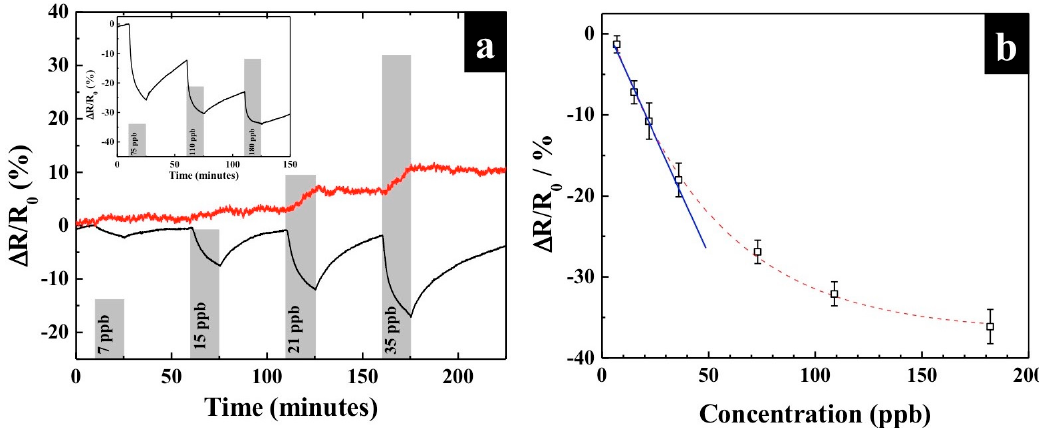
Figure 2. ( a ) Dynamic responses ( Δ R / R 0 ) of KI-functionalized PANI nanothin film (KI-PANI, black) and pristine PANI (red) sensors to 7–35 ppb of ozone gas at 25 °C and 50% RH. The inset shows sensing response of 75–180 ppb of ozone gas; ( b ) Calibration curve of KI-PANI sensor to 7–180 ppb of ozone gas at 25 °C and 50% RH.